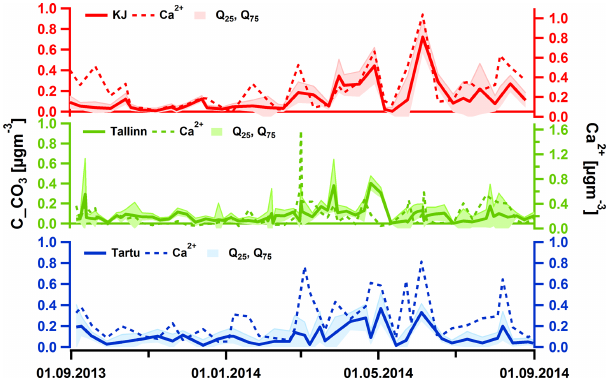
Figure 6. Time series of the inorganic dust factor [C_CO 3 ] with interquartile ranges ( Q 25 and Q 75 ) and of Ca 2 + per